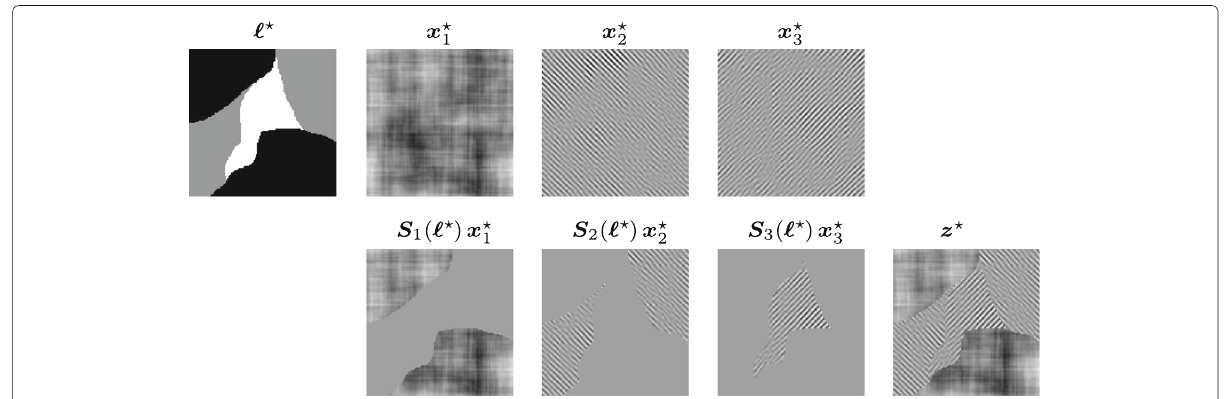
Fig. 1 Image forming process (see Eq. (4)) in a case with K = 3 texture classes. Left: true label (cid:2) (cid:10) . Central panel: three images x (cid:10) 1 , x (cid:10) 2 and x (cid:10) 3 (top) and extracted parts S 1 ( (cid:2) (cid:10) ) x (cid:10) 1 , S 2 ( (cid:2) (cid:10) ) x (cid:10) 2 and S 3 ( (cid:2) (cid:10) ) x (cid:10) 3 (bottom). Right: true image z (cid:10)